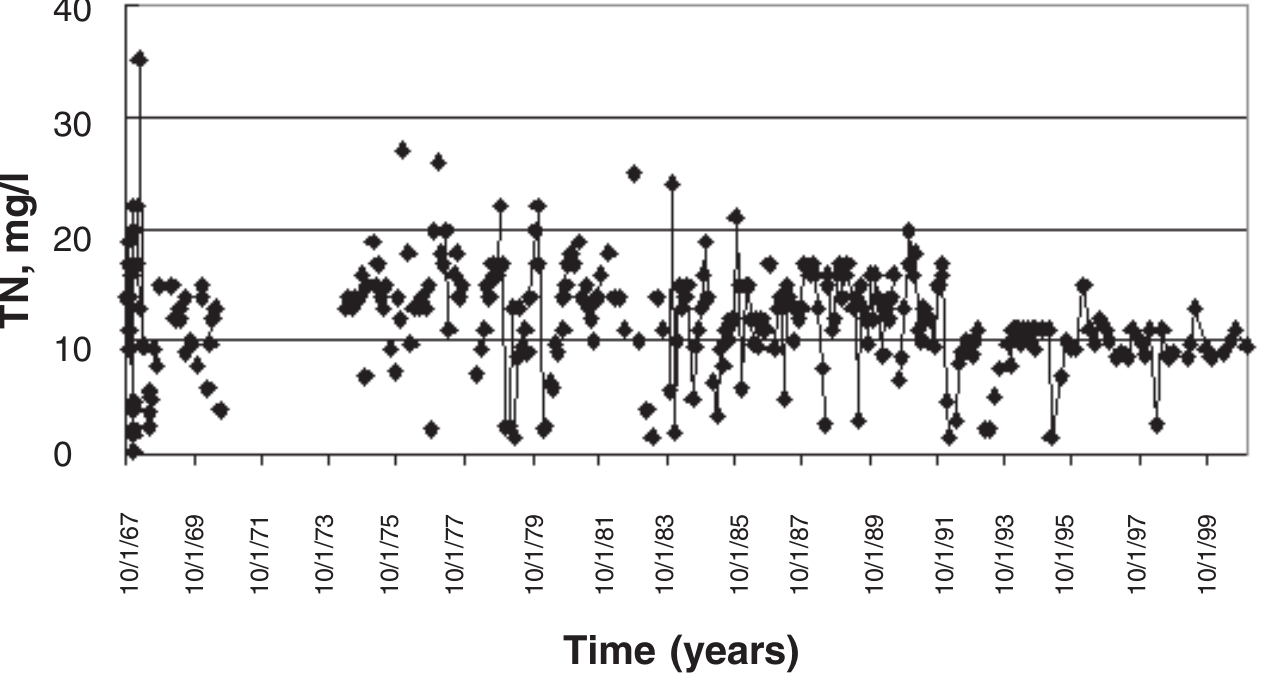
FIGURE 3. Total N in the Gila River as it exits the CAP ecosystem, 1967–2000 (U.S. Geological